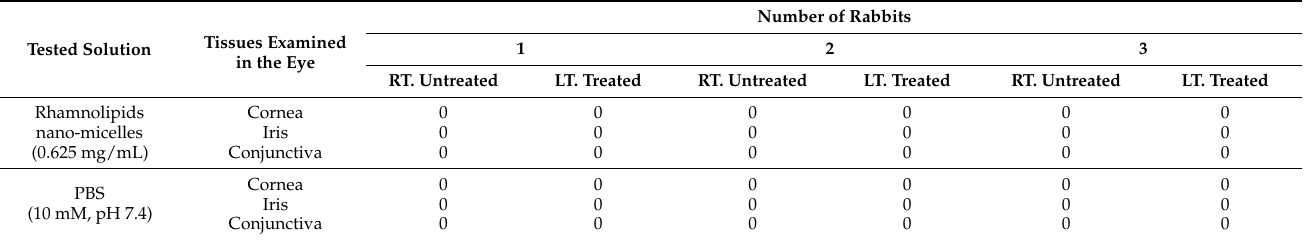
Table 2. Evaluation of eye irritations following treatment with rhamnolipids nano-micelles solution and PBS, vehicle used to disperse rhamnolipids nano-micelles *.